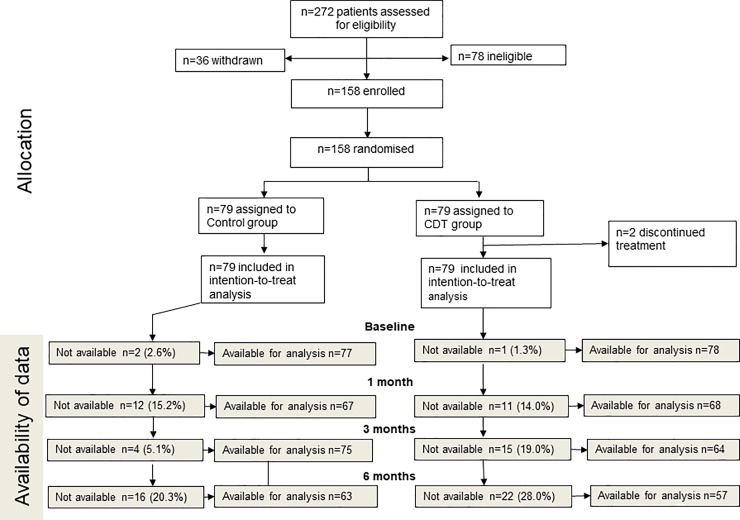
Patient flow diagram.